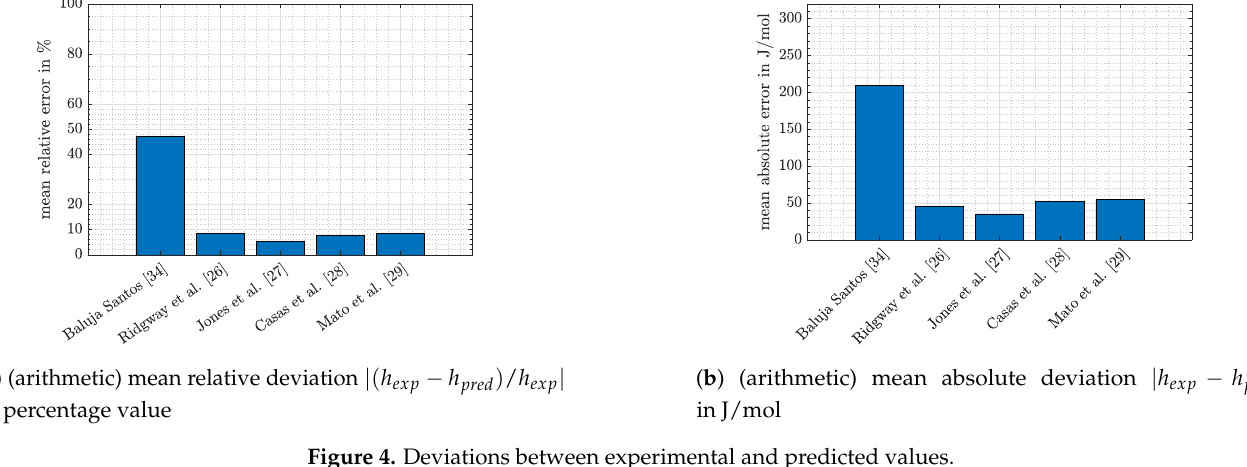
Figure 4. Deviations between experimental and predicted values. Except for the data of Baluja Santos [34], absolute mean deviations were below 55 J/mol and relative mean errors were below 10%. Together with the other literature